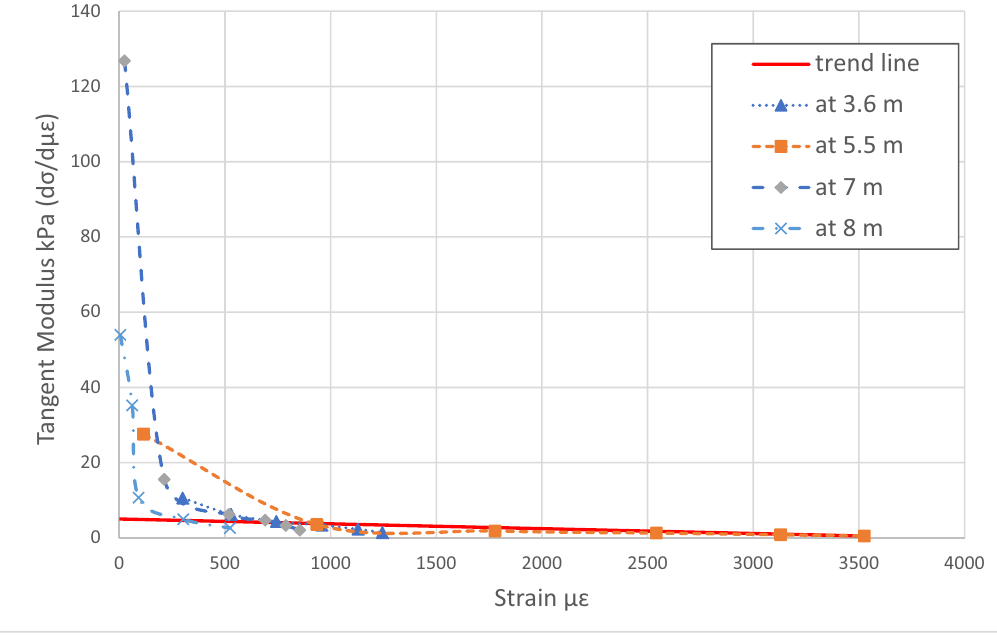
Figure 18: Tangent modulus diagram.